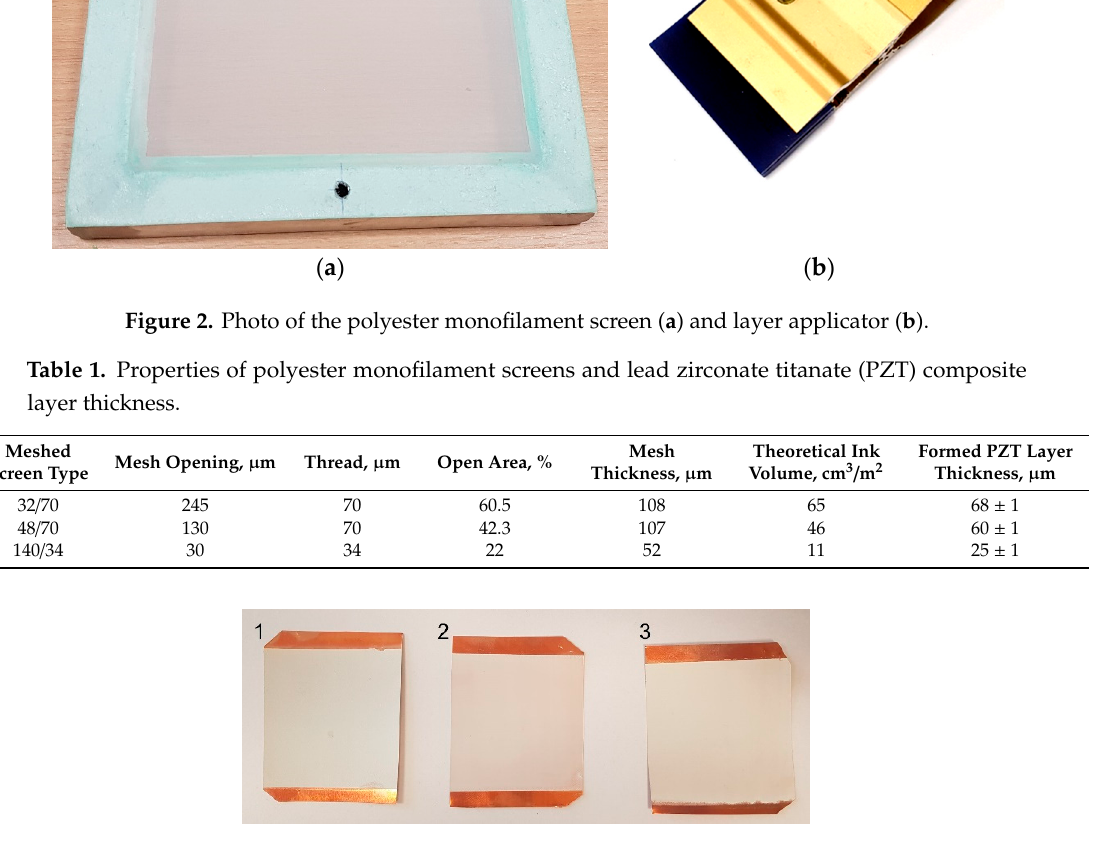
Figure 3. Samples of the coating on copper foil: 1, PZT/poly(methyl methacrylate) (PMMA); 2, PZT/polystyrene (PS); 3, PZT/polyvinyl butyral (PVB).